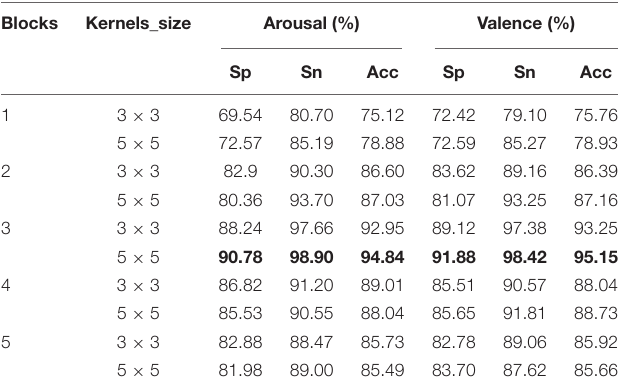
TABLE 3 | The classification results of the DA-RCNN model configured with different